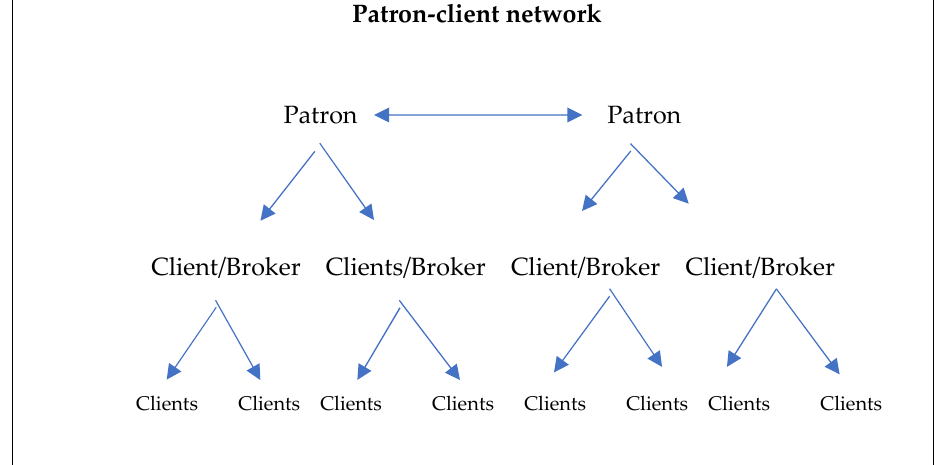
Figure 1. Patron-client network.